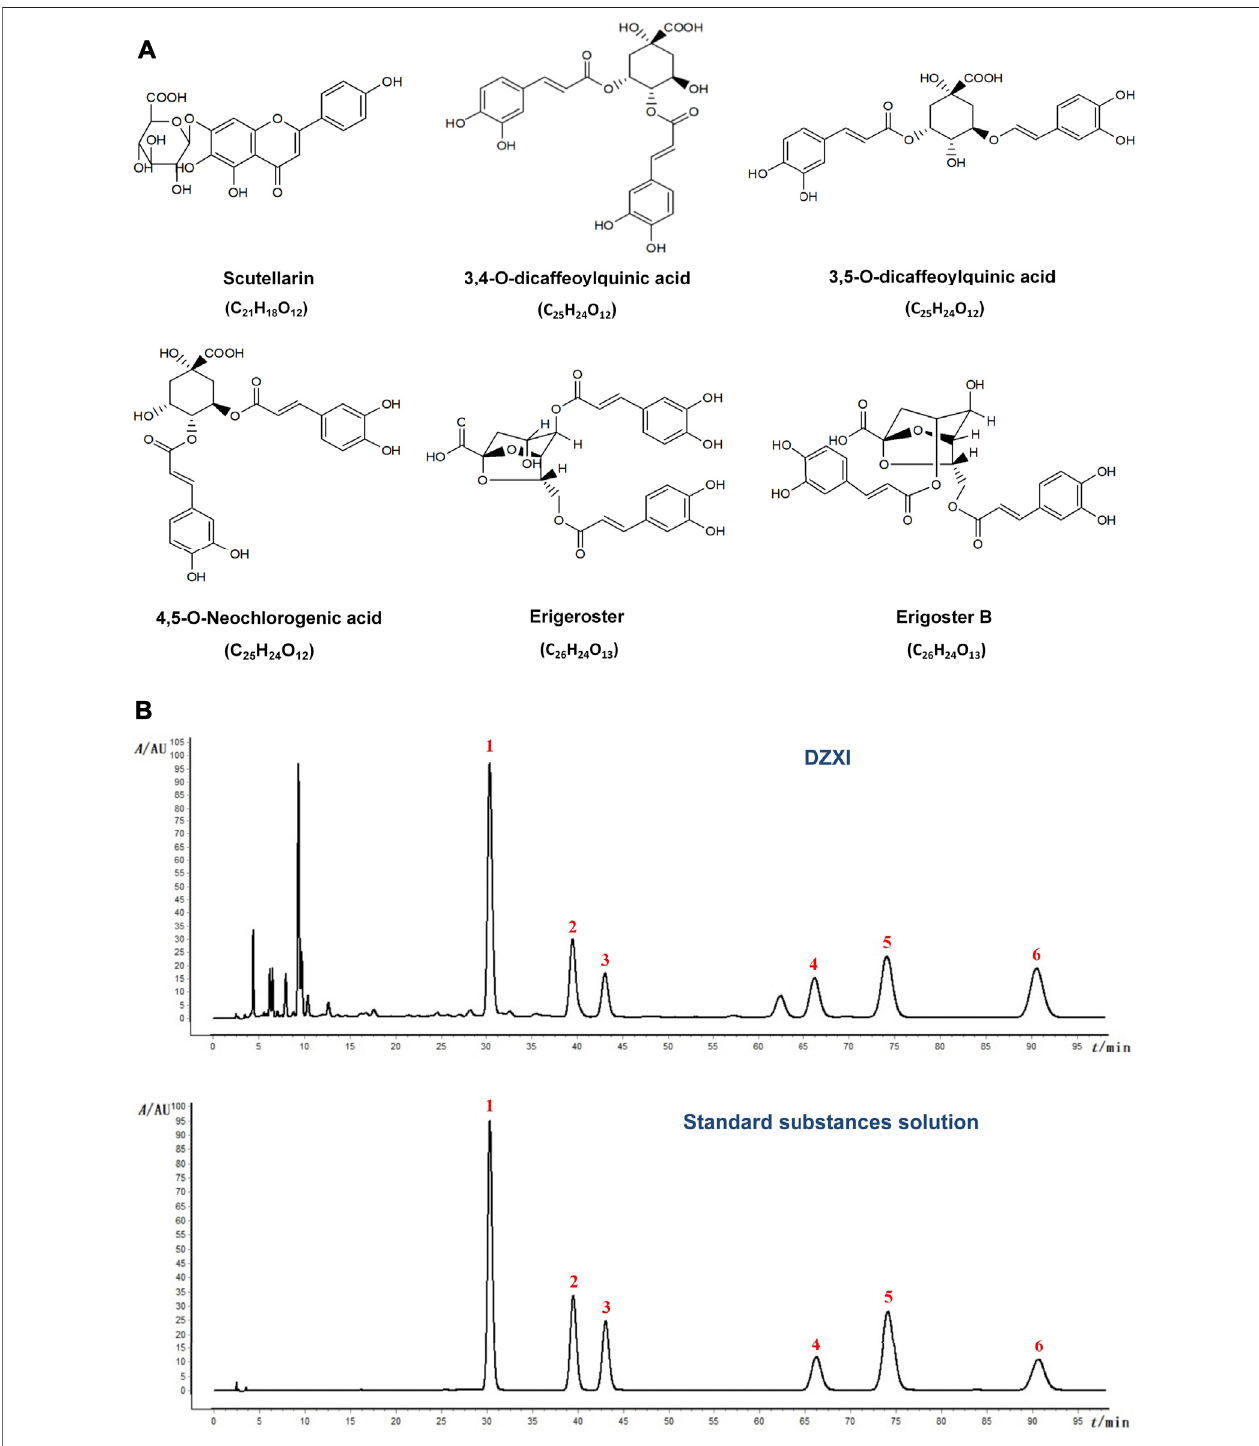
FIGURE1|(A) ThechemicalstructureandmolecularformulaofactivecompoundsinDZXI. (B) ChromatogramofHPLCanalysisofDZXIandstandardsubstances solution.Theactivecompounds:1.scutellarin;2.3,4-O-dicaffeoylquinicacid;3.3,5-O-dicaffeoylquinicacid;4.erigosterB;5.4,5-O-dicaffeoylquinicacid;6.erigeroster.